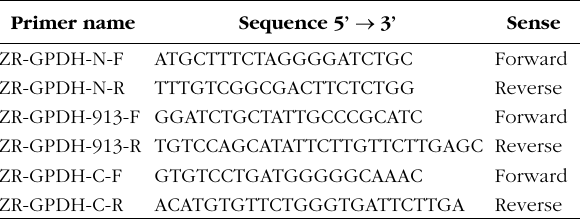
Table I. – Primer sequences used for Ixodes ricinus glycerol-3- phosphate dehydrogenase gene coding regions